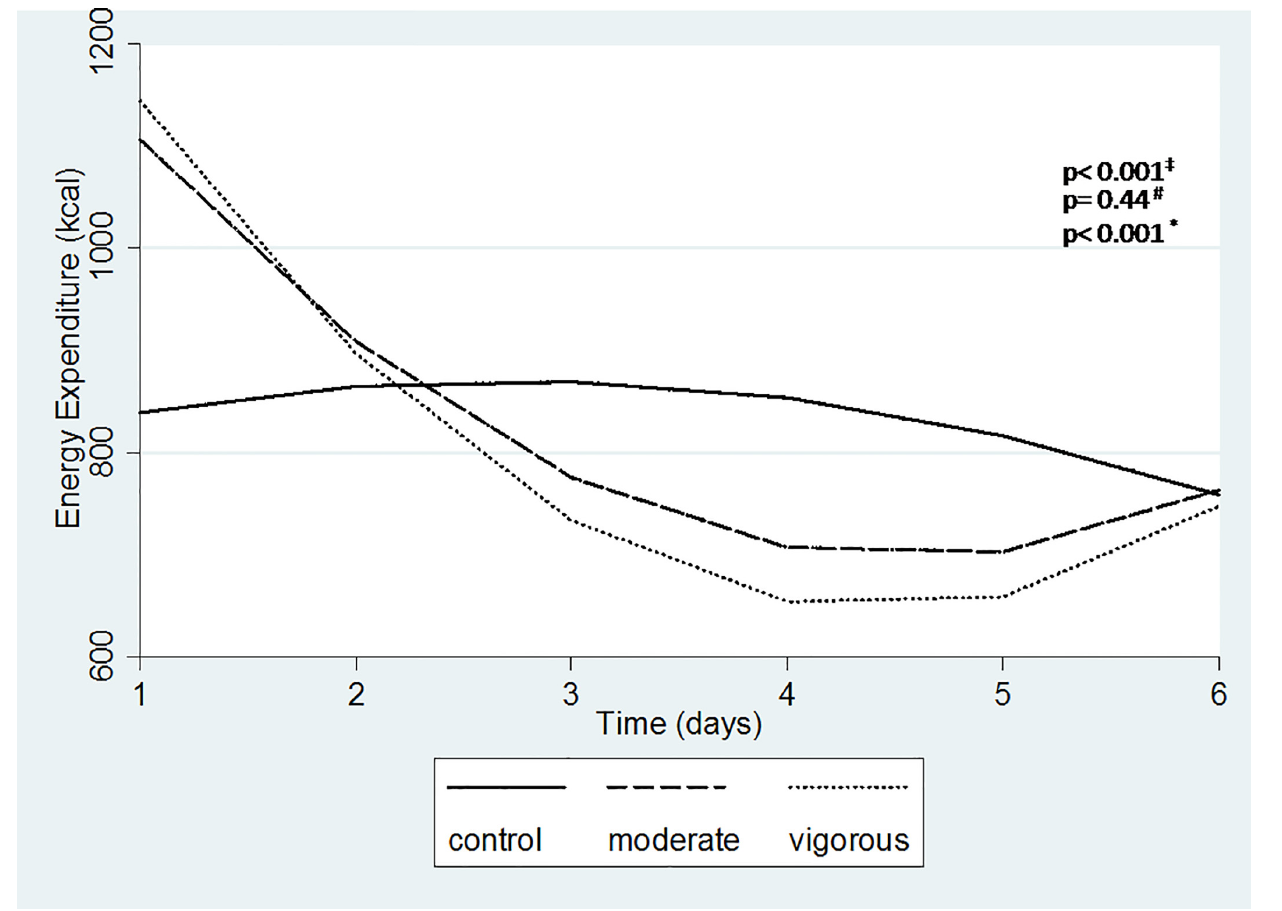
Fig 3. Estimated mean values of energy expenditure per day for 6 days monitoring. Linear mixed model with time, group * time, time * time, group * time * time, adjusted for EE for the 1st hour. ‡ moderate vs. control; # moderate vs. vigorous; * vigorous vs.